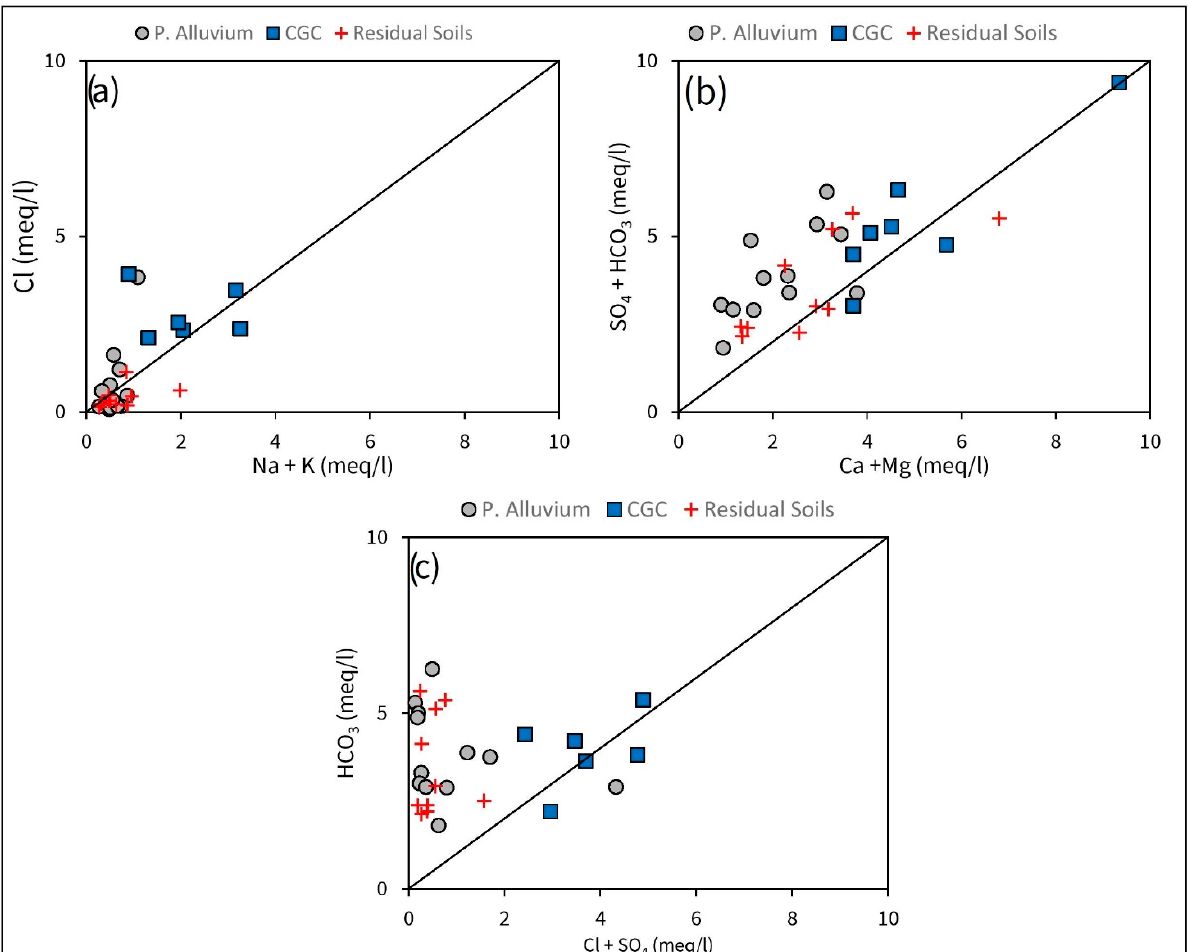
Figure 7. Bivariate plots of ionic relation. ( a ) Cl vs. Na + K. ( b ) SO 4 + HCO 3 vs. Ca + Mg. ( c ) HCO 3 vs. (Cl + SO 4 ).